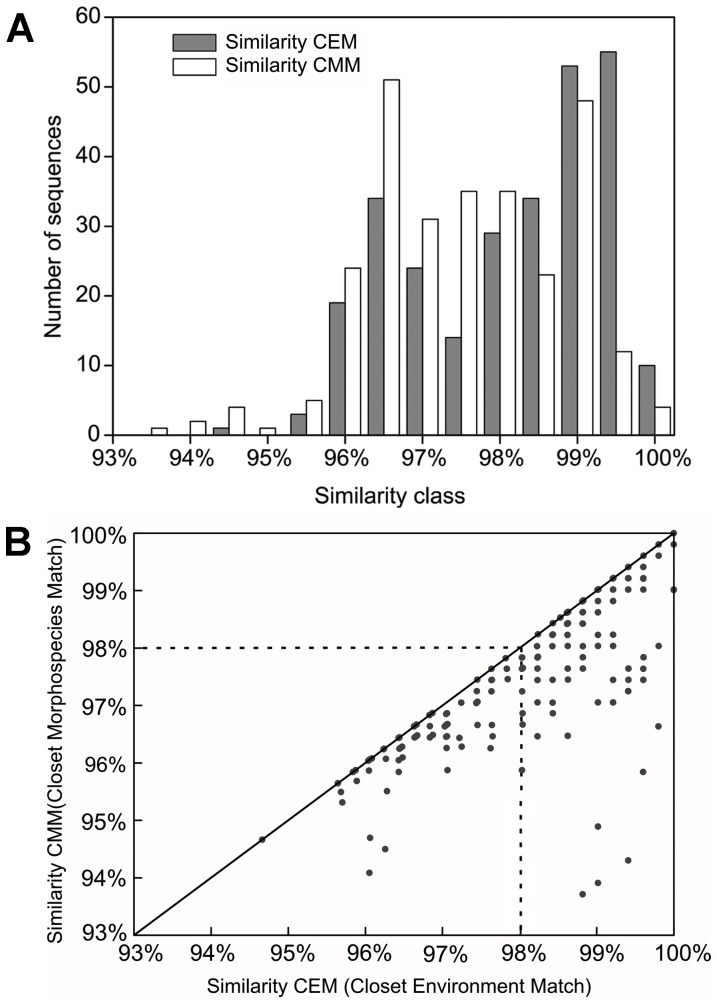
Histogram and dispersion plots of the CEM and CMM similarities for sequences.Novelty analysis of the 276 sequences of oligotrich and choreotrich 18S rRNA genes amplified from environmental DNA of the nanoplanktonic fractions. (A) Histogram showing the distribution of similarities against closest environmental match (CEM) and closest morphospecies match (CMM) of all sequences, in 0.5% similarity classes. (B) Dispersion plot of the CEM and CMM similarities for each sequence.